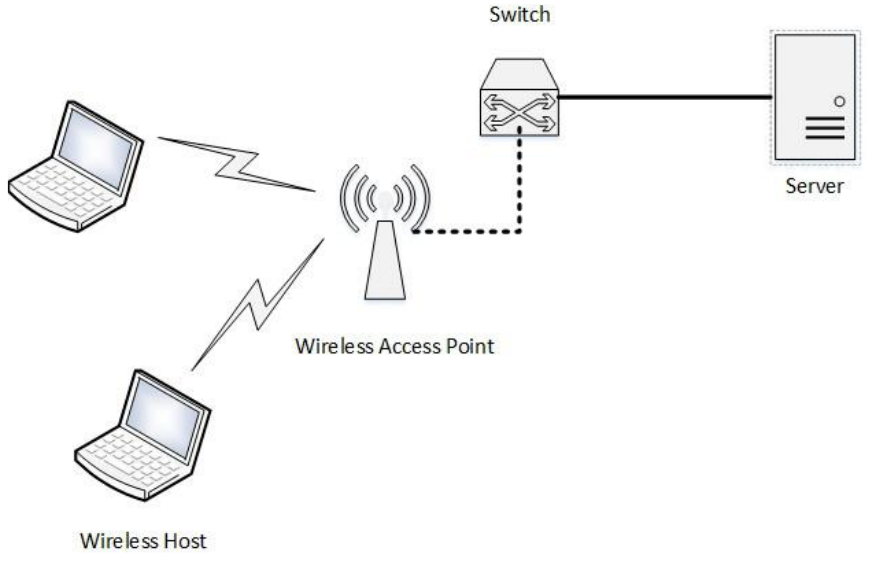
Figure 4. Mininet-WiFi Experiment Topology.